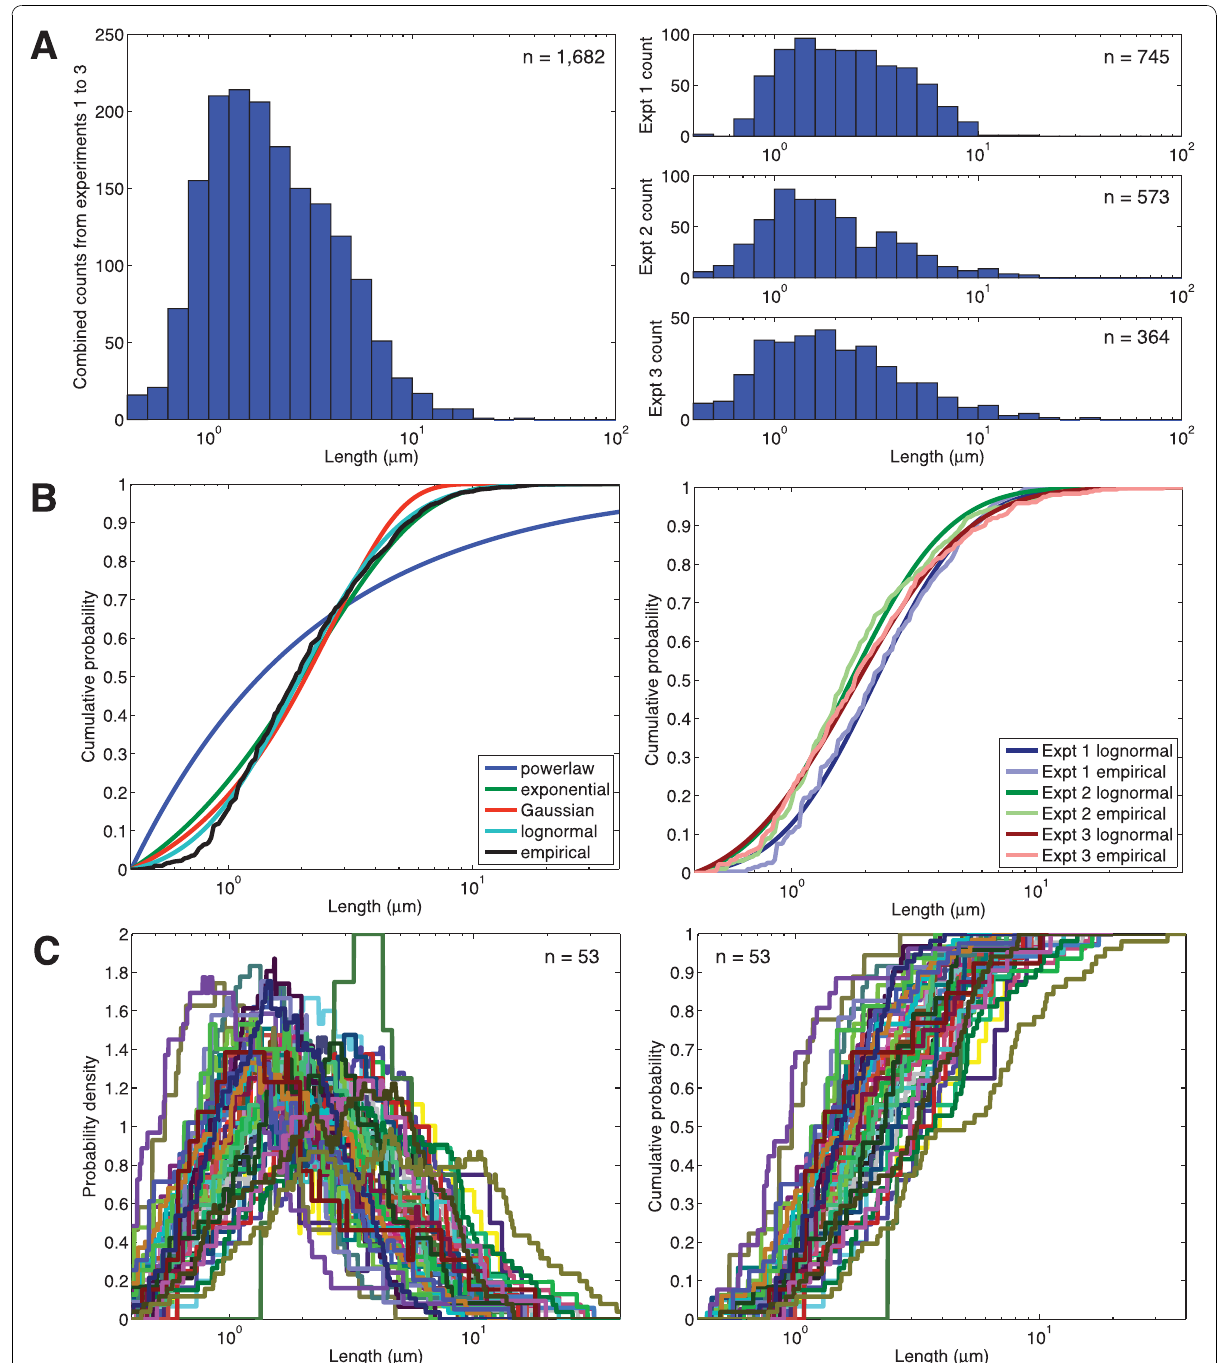
Figure 2 Filopodia length distribution is unimodal and best fits a lognormal model . (A) Histogram of all the filopodia lengths (n = 1,682), and independent experiments 1, 2 and 3 with n = 745, n = 573 and n = 364 respectively. (B) Empirical cumulative distribution functions (CDFs) of lengths with the lognormal and other statistical models for all the experiments combined and each independent experiment 1, 2 and 3. (C) Empirical PDFs and CDFs of filopodia lengths for 53